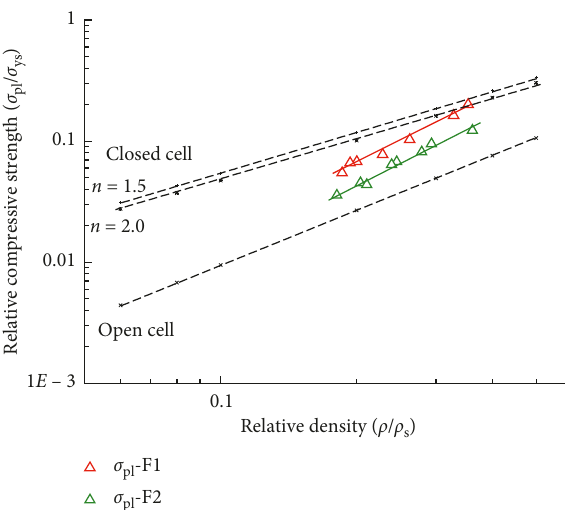
pl / σ ys , plotted against